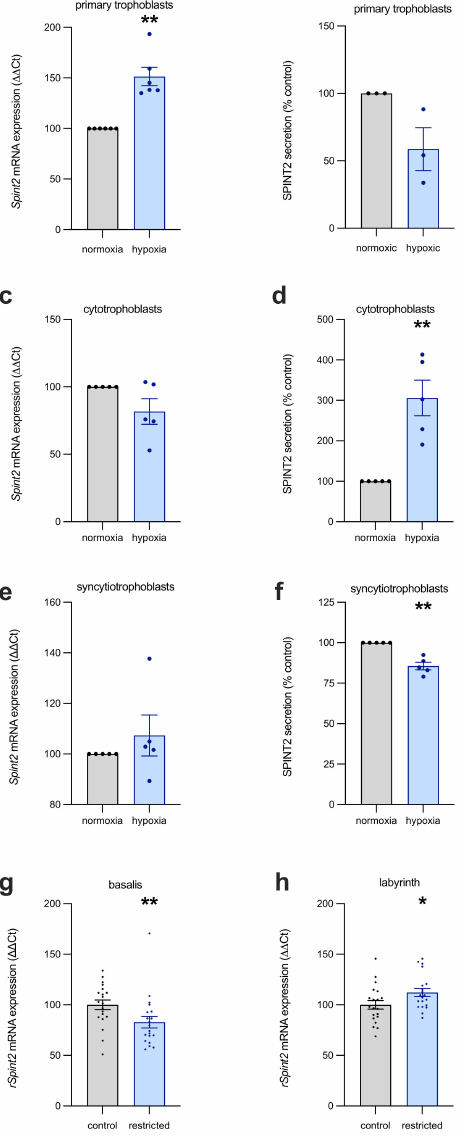
Figure 3. The effect of hypoxia on SPINT2 expression in placental cells. SPINT2 mRNA and protein secretion was measured in the following three types of trophoblast cultures: primary trophoblasts isolated from term placentas, and first-trimester cytotrophoblast and syncytiotrophoblast from a stem cell line. In the term primary trophoblasts ( a ), SPINT2 transcripts were significantly increased in response to hypoxia, while secreted protein levels ( b ) were not changed. Hypoxic conditions caused no alteration to the first-trimester cytotrophoblast stem cell SPINT2 mRNA ( c ), but did significantly increase the levels of SPINT2 secretion ( d ) compared to normoxic controls. The syncytialised first- trimester stem cells had no change in mRNA ( e ), although they did demonstrate decreased SPINT2 secretion ( f ). Experiments were repeated n = 3–5 times; data are expressed as mean ± SEM. In placentas from a rat model of uteroplacental insufficiency, changes were identified in rat SPINT2 mRNA ( rSpint2 ) expression in both the basalis ( g ) and labyrinth ( h ) zones, being depressed and elevated, respectively. Each data point represents an individual rat placenta; data are expressed as median ± IQR; * p < 0.05, ** p <